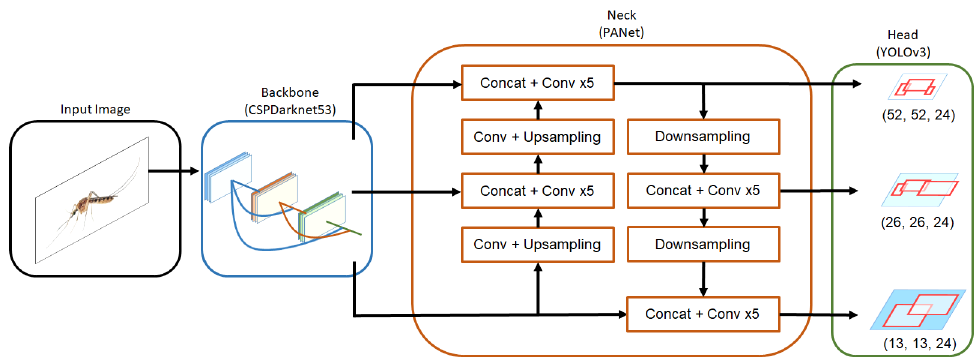
Figure 5. YOLO V4 block diagram.